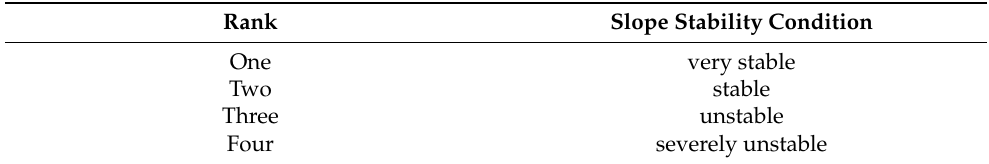
Table 4. Grade classification of slope decision attributes.